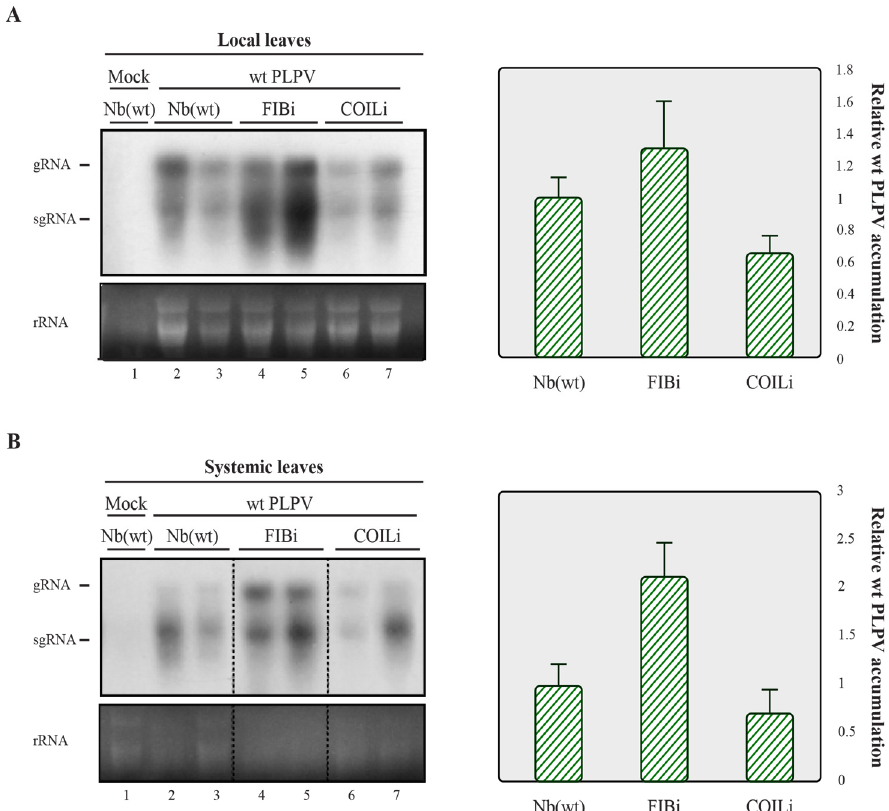
Figure 2. Accumulation of wt PLPV in lines of N. benthamiana with downregulated fibrillarin or coilin content. The wt PLPV was agroinoculated in wt and in FIBi and COILi N. benthamiana lines. Northern blot (left) and RT-qPCR (right) analyses of local ( A ) and systemic ( B ) leaves collected at 7 dpi and 30 dpi, respectively. For Northern blot, a PLPV- specific riboprobe was employed. Positions of the PLPV genomic (g) and subgenomic (sg) RNAs are indicated at the margin of the blots, and ethidium bromide staining of rRNAs is included below the blots as loading controls. Two distinct samples are shown for each virus–plant line combination. A mock-inoculated plant was included as negative control. In the graphs to the right, corresponding to the RT-qPCR measurement of relative PLPV accumulation, the bars depict the standard deviation from three independent biological replicates. The statistical significance was evaluated using a paired t-test (no significant differences were detected).